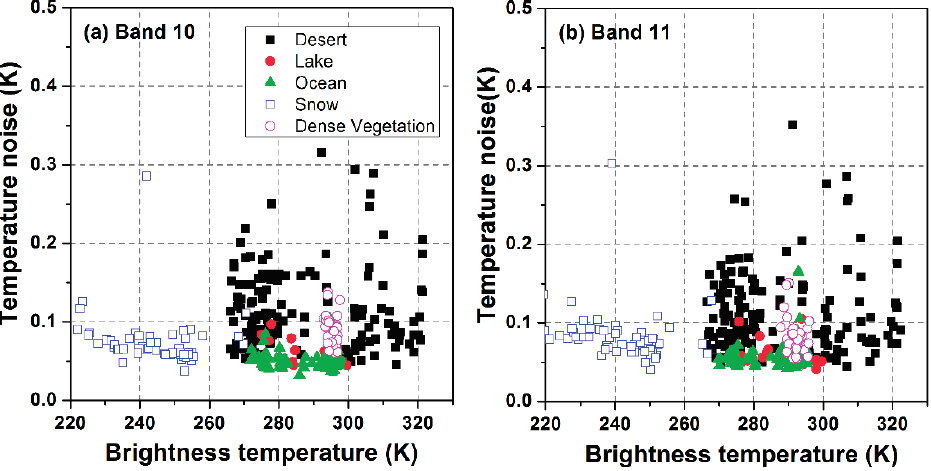
Figure 2. Temperature noise of the TIRS two bands for different land covers and brightness